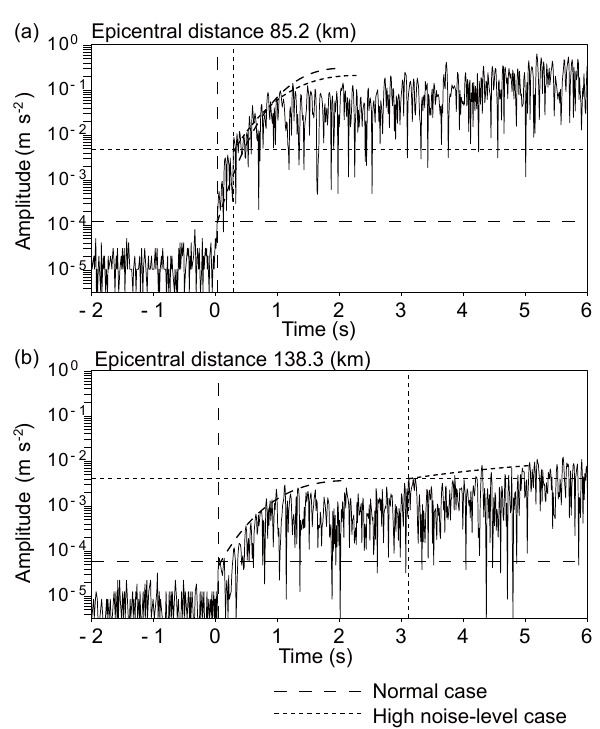
Figure 1. Examples of epicentral distance estimation using the method of Odaka et al. (2003). (a) Record of the 2003 Tokachi-oki earthquake on 26 September 2003; (b) record of the 2011 Great East Japan Earthquake on 11 March 2011. Two levels of noise were as- sumed. Long-dash lines: the curve of Bt exp ( − At) (refer to Odaka et al., 2003) was fitted to the part where amplitude exceeded dou- ble the noise level. Short-dash lines: the curve was fitted to the part where the amplitude exceeded 0.004ms − 2 , which was assumed to be twice the noise level of an MEMS